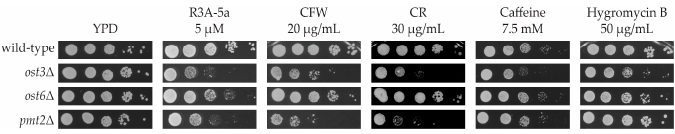
Figure 2. Analysis of cell growth in the presence of different drugs. Three microliters of serial 10× dilutions of cells starting with 6 × 10 5 cells (left) were spotted on solid media containing no drug